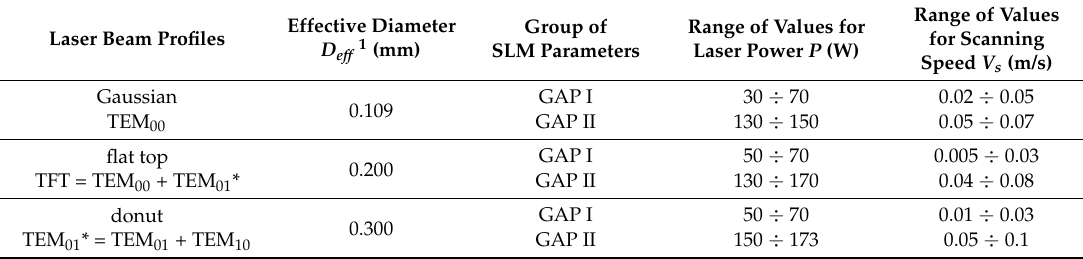
Table 2. Process parameters for CoCrMo powder with variation of laser beam profiles.